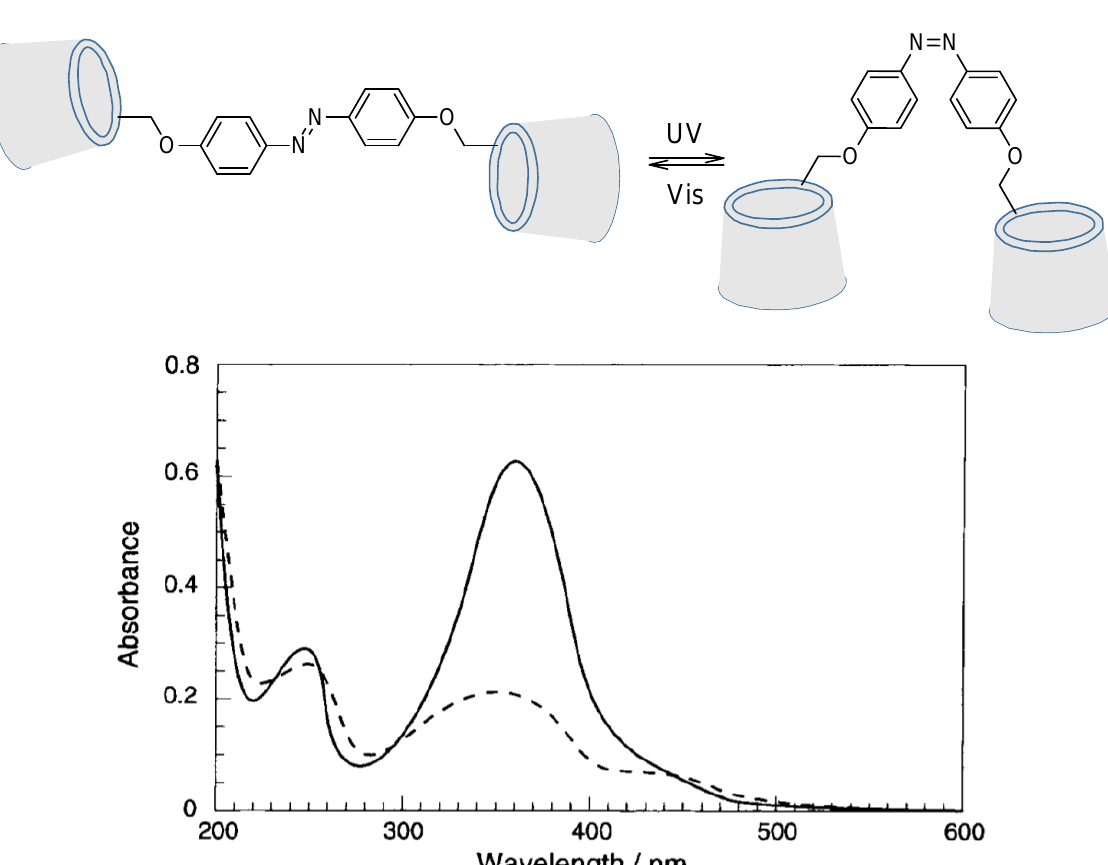
Figure 21. Absorption spectra of 1 before (-) and after (- - -) photoirradiation. Reuse (reprint) with permission of Aoyagi, T.; Ueno, A.; Fukushima, M.; Osa, T. Synthesis and Photoisomerization of an Azobenzene Derivative Bearing Two β -Cyclodextrin Units at Both Ends. Macromolecular Rapid Communications 1998 , 19 , 103–105, doi:10.1002/(SICI)1521-